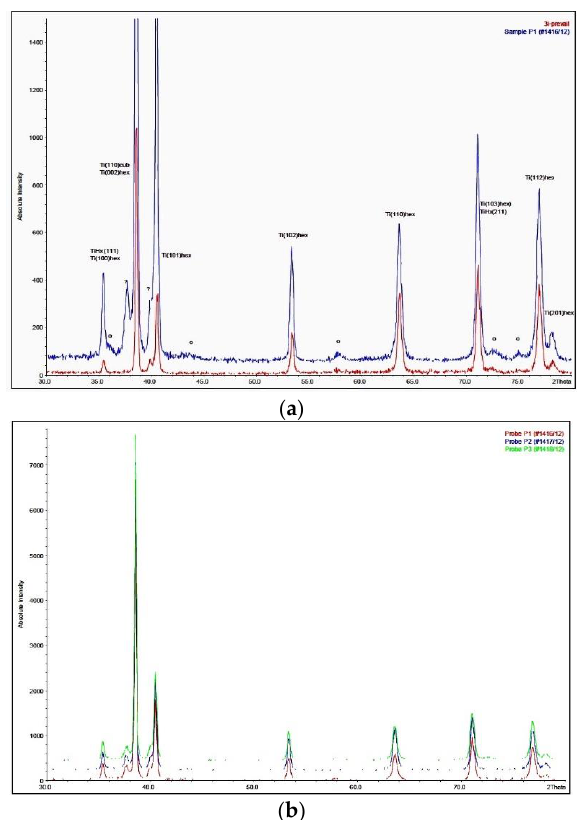
Figure 3. XRD di ff raction of the implant surface. ( a ) XRD di ff raction of the implant surface (blue line) compared to the di ff raction of another etched Ti grade 5 alloy (Osseotite, red line). The peak at 38 degrees could not be identified, it was neither alumina nor hydride; ( b ) XRD di ff raction on 3 distinct implants. The spectra were